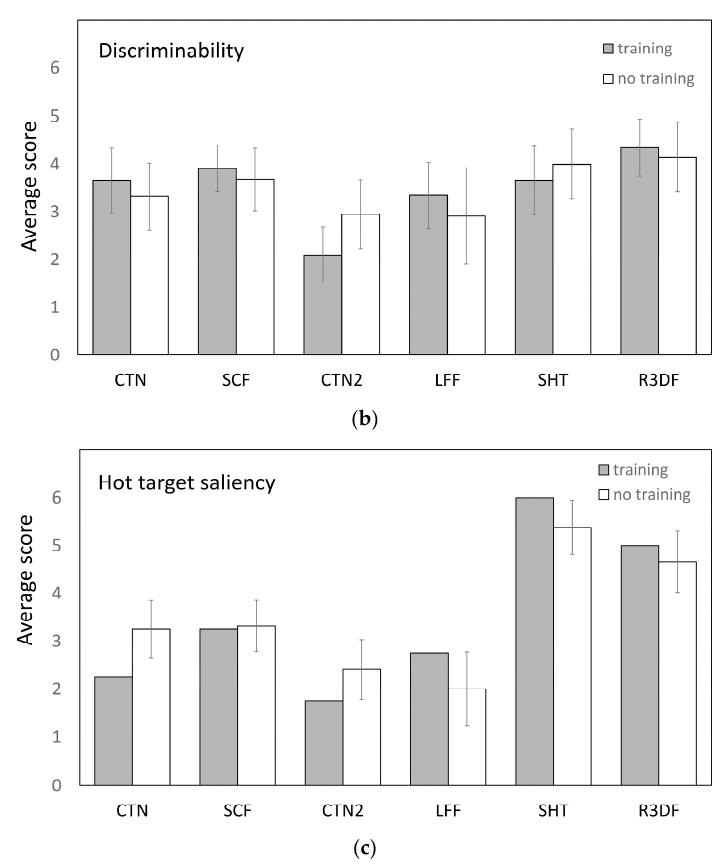
Figure 17. Mean ranking scores for ( a ) Naturalness; ( b ) Discriminability; and ( c ) Saliency of hot targets, for each of the six color fusion methods (CTN, SCF, CTN2, LFF, SHT, R3DF). Filled (empty) bars represent the mean ranking scores for methods applied to images that were (not) in their training set. Filled (open) bars represent the scores when the methods were applied to images that were (not) included their training set. Error bars represent the standard error of the mean.